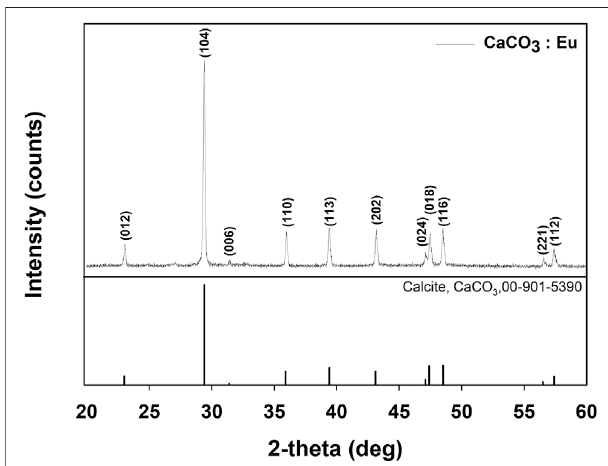
FIGURE 2 | XRD pattern of CaCO 3 : Eu.